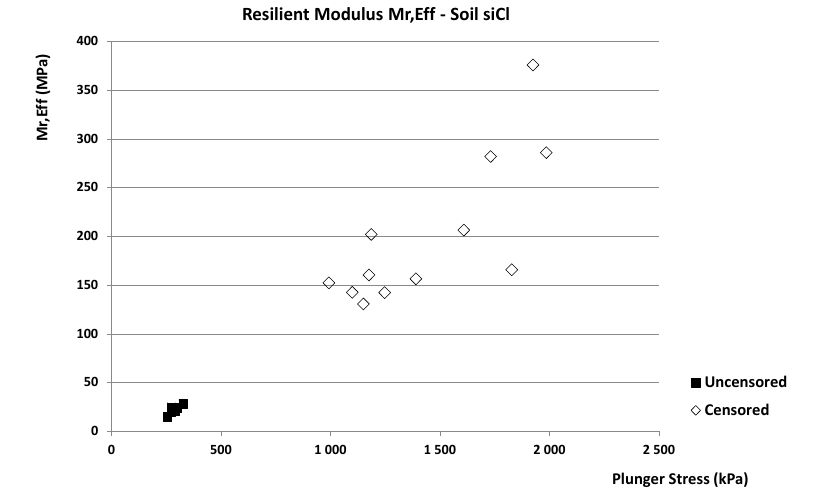
Figure 4. Resilient modulus M r,eff for soil siCl.